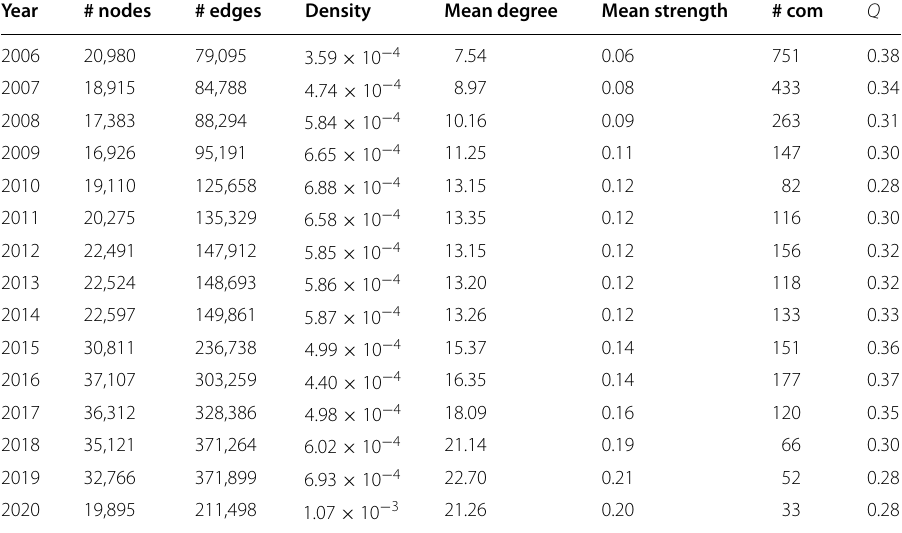
The network size, number of edges, edge density, mean degree and strength, number of communities, and modularity of community detection are exhibited